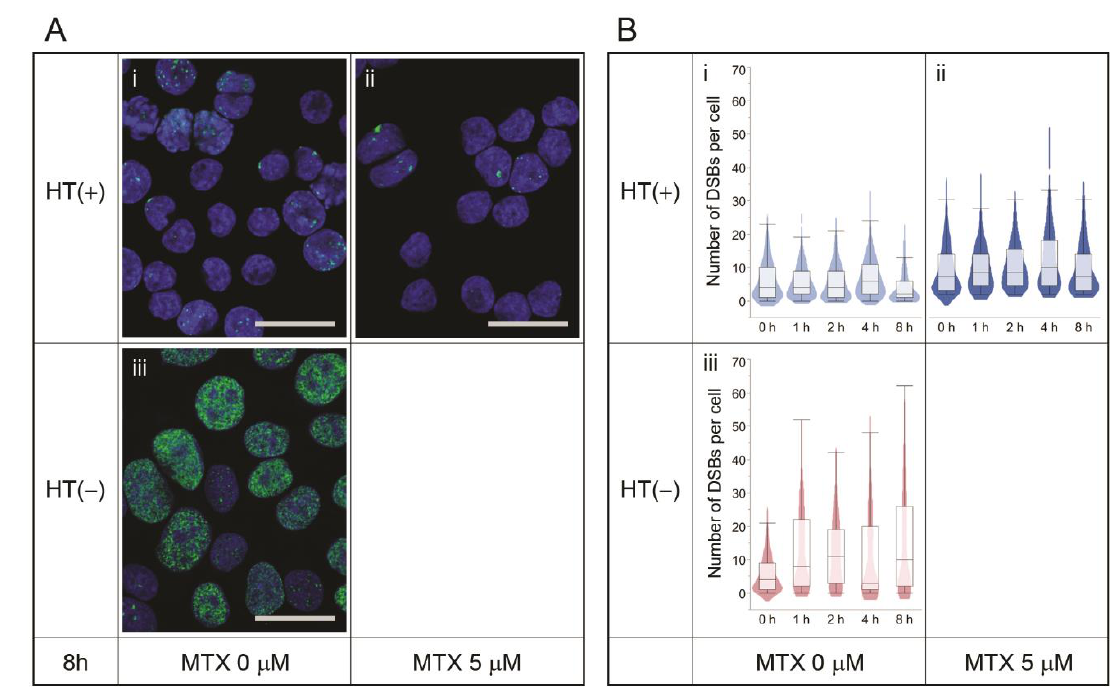
Figure 4. ( A ) Immunocytochemistry of γ H2AX (green foci) on Dhfr -deficient (CHO-DUK) cells in the presence or absence of hypoxanthine/thymidine (HT) and MTX or both. The nuclei are counterstained with DAPI. ( B ) The number of DSBs per cell and their distribution at each time point. The scale bars are 20 µm.